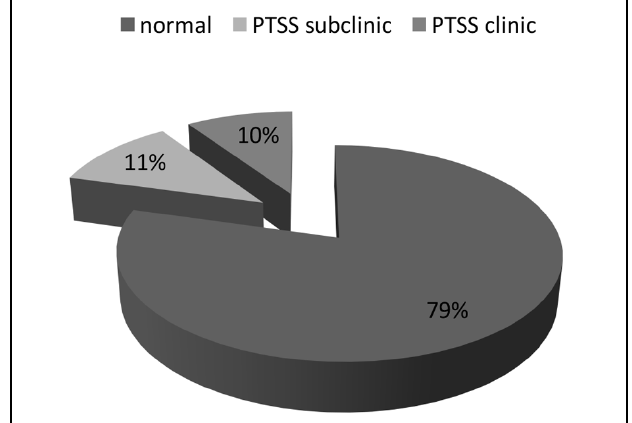
FIGURE 1 | Post-traumatic stress symptom (PTSS) presence in childhood cancer